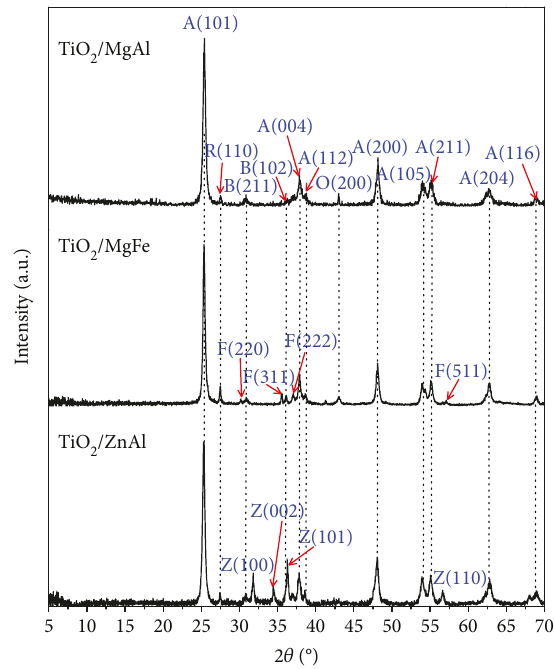
Figure 1: XRD patterns for TiO (periclase), A (TiO (magnetite), and Z (zincite).